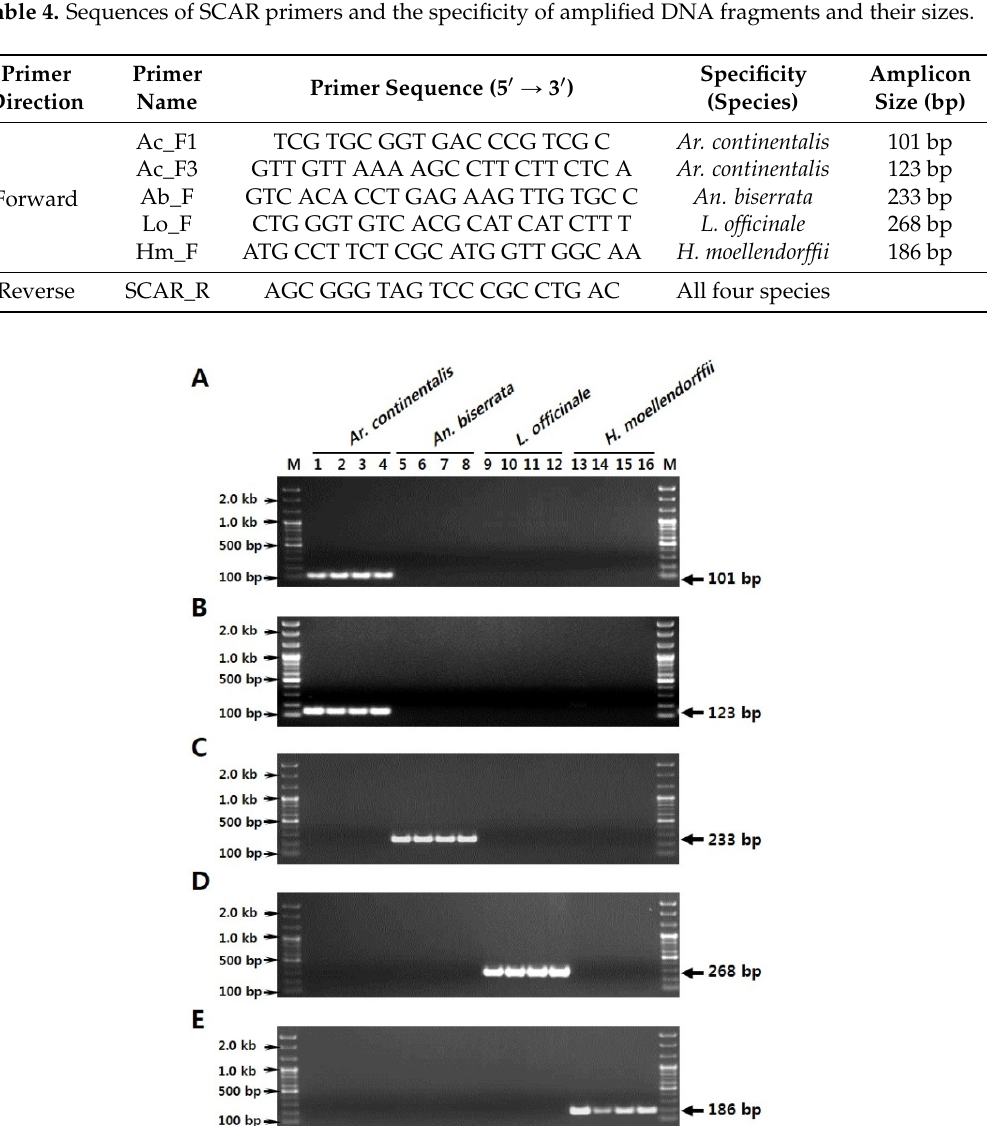
Table 4. Sequences of SCAR primers and the specificity of amplified DNA fragments and their sizes.